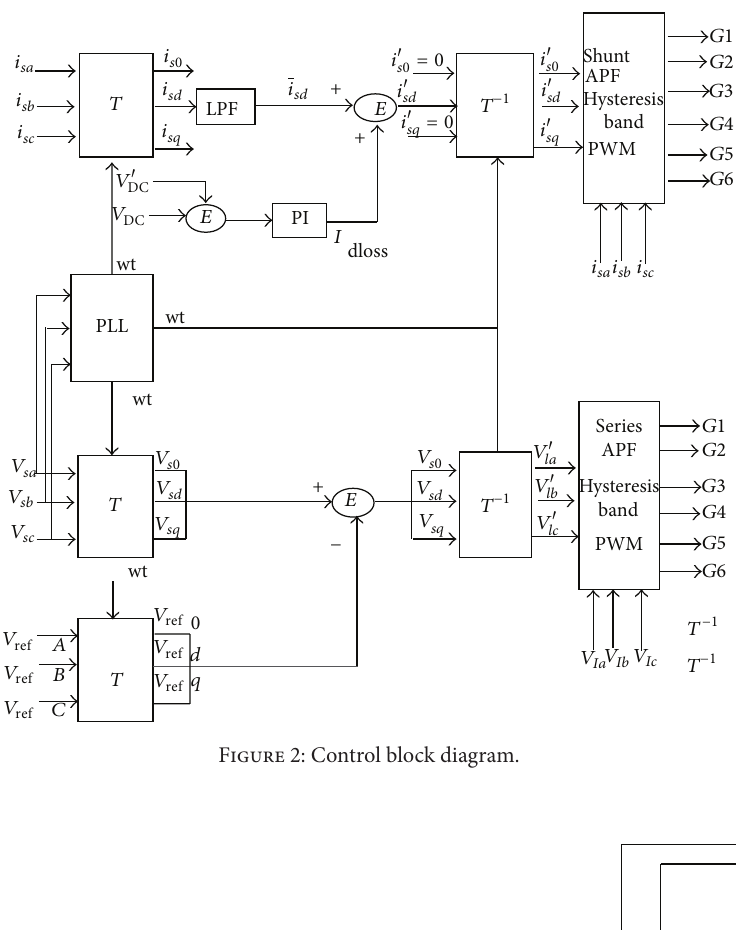
Figure 2: Control block diagram.